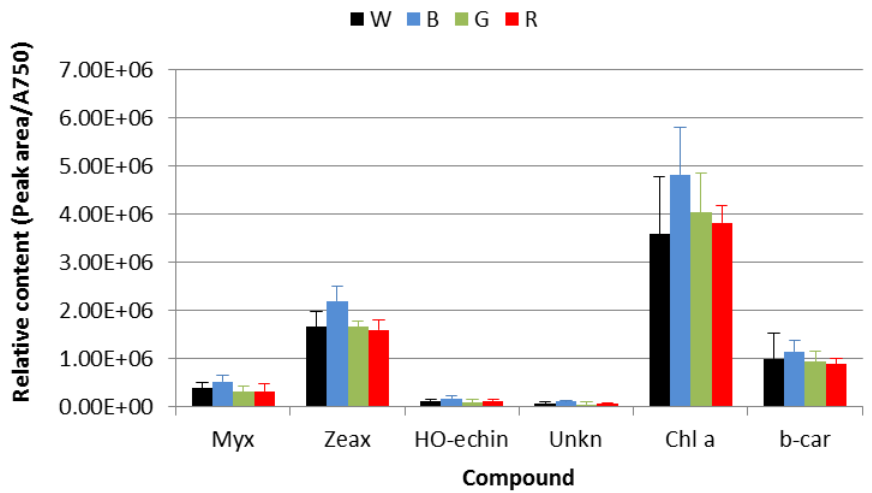
Figure 3. Relative content normalized to the absorbance at 750 nm of the main photosynthetic pigments as measured by HPLC-DAD from a methanolic extract of Synechococcus sp. cells. Legend: W, transparent filter; B, blue filter; G, green filter; and R, red filter. X-axes legend: Myx, myxoxanthophyll; Zeax, zeaxanthin; HO-echin, hydroxy-echinenone; Unk, unknown (echinenone related); Chl a, chlorophyll a ; b-car, β-carotene.